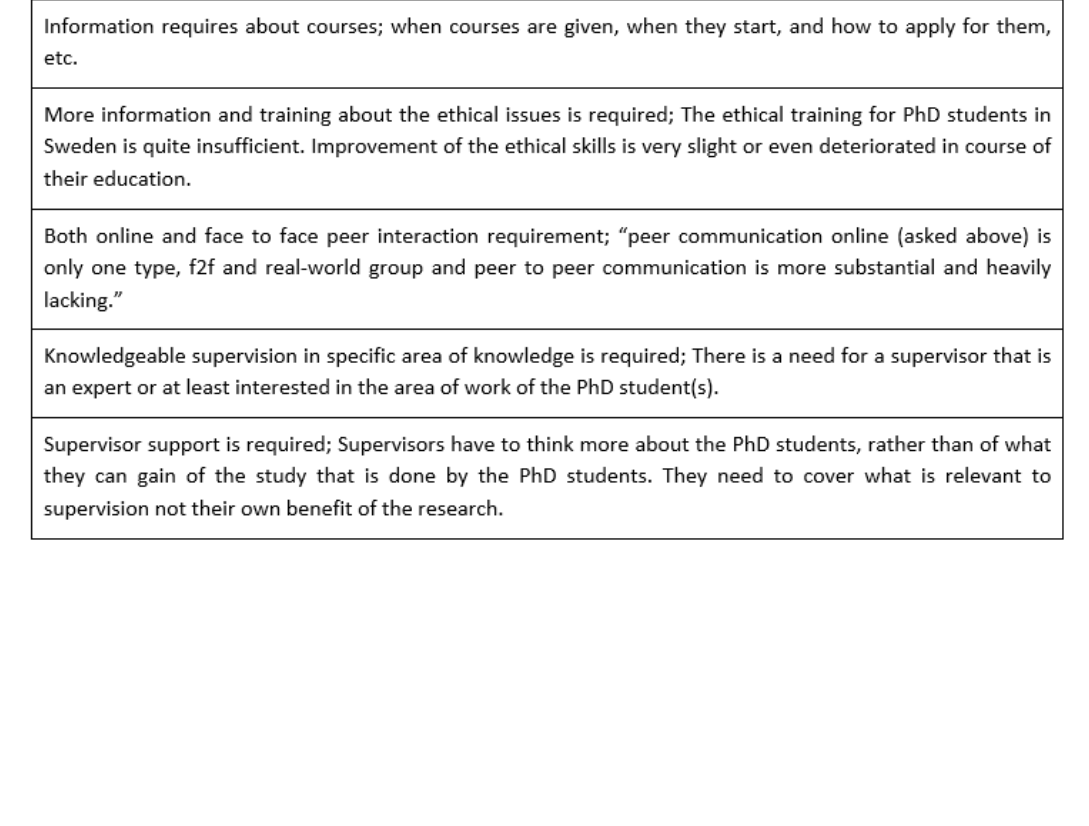
Result of the Open-Ended Questions Regarding the PhD Students’ Suggestions About How to Reduce the